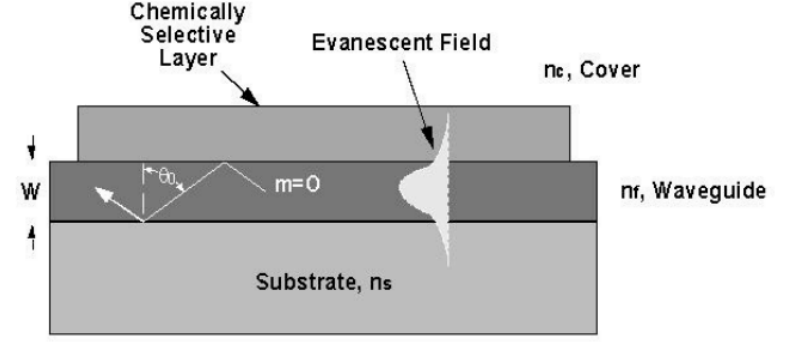
Figure 1. Waveguide cross-section illustrating zig-zag ray model for optical